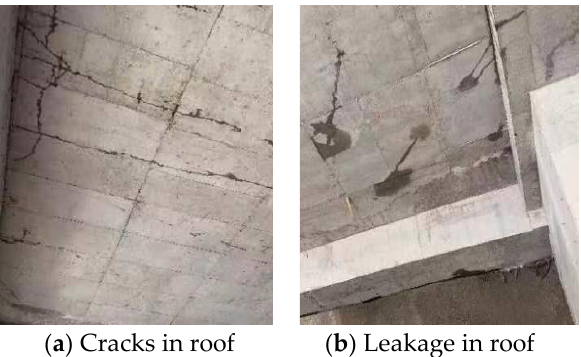
Figure 1. Photograph of the cracked concrete structure in a metro station in Xi’an